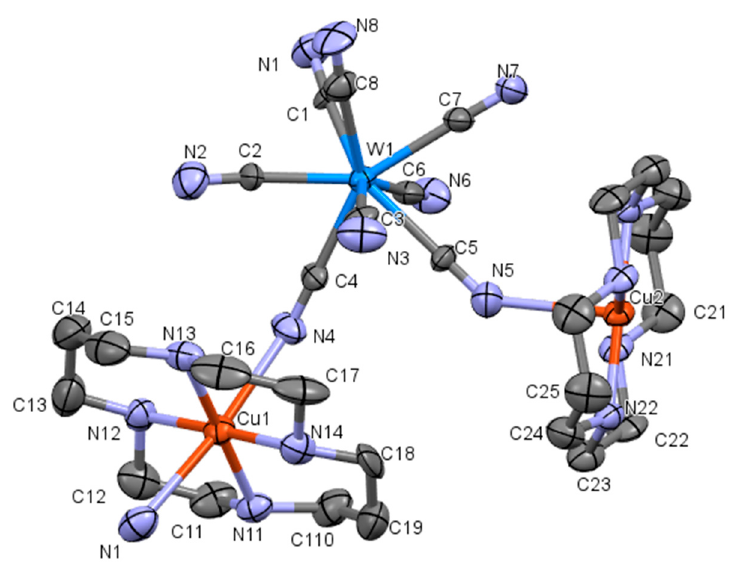
Figure 1. The asymmetric unit of 1 with atom numbering; ellipsoids at 50% probability. Table 2. Selected bond lengths (Å) and angles (°) in 1·5H 2 O and 1 .